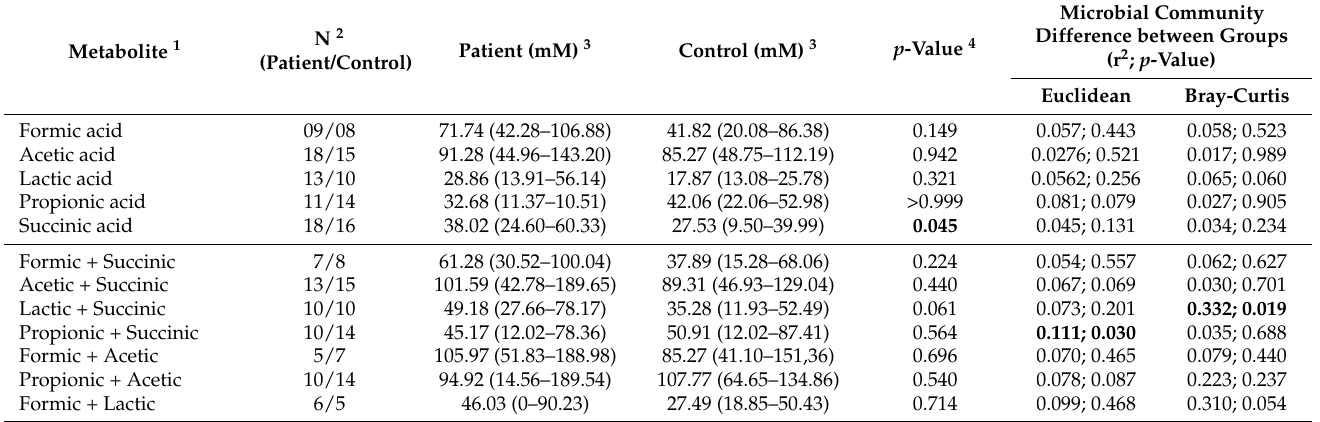
Table 1. Metabolite quantification between patient and control group.